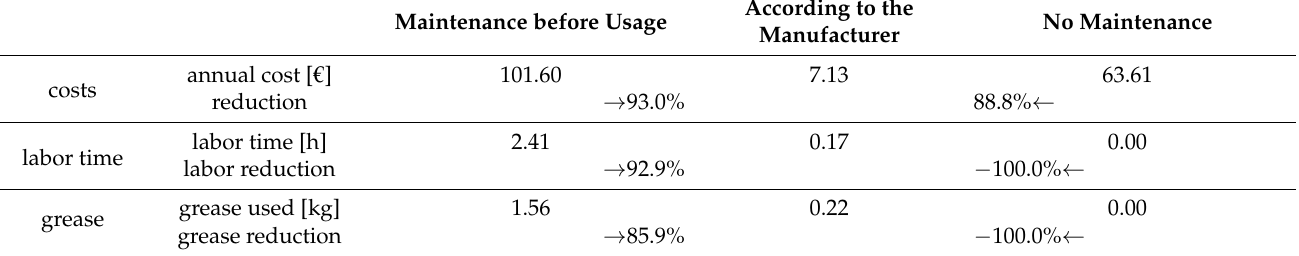
Table 5. Reduction of costs, labor time and grease for the feed mixer from the extreme scenarios to when maintenance is carried out as specified by the manufacturer; assumption for the feed mixer: maintenance is carried out once a week instead of daily.